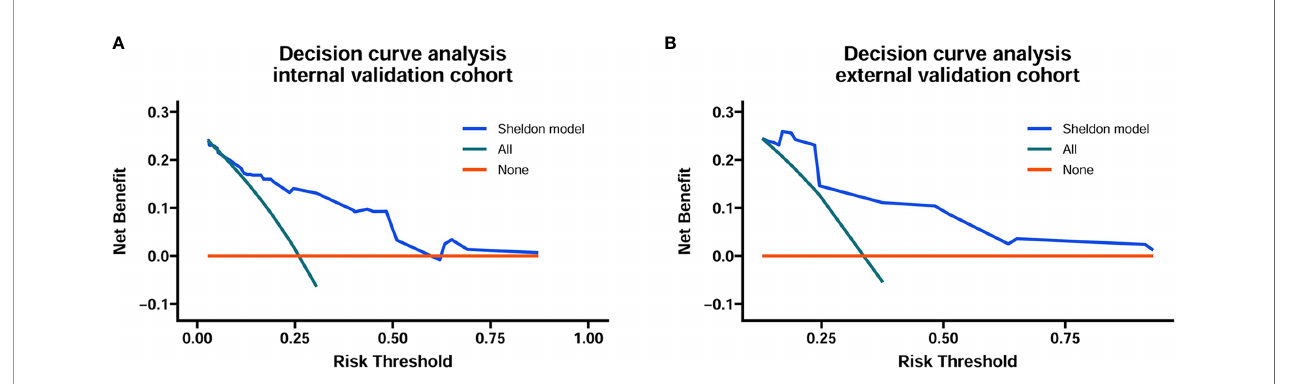
FIGURE 5 | Decision curve analysis for the Sheldon model in the internal (A) and external (B) training cohort. The horizontal solid orange line represents the assumption that no patients will die, and the solid green line represents the assumption that all patients will die. On decision curve analyses, the nomogram showed superior net bene fi t across all range of